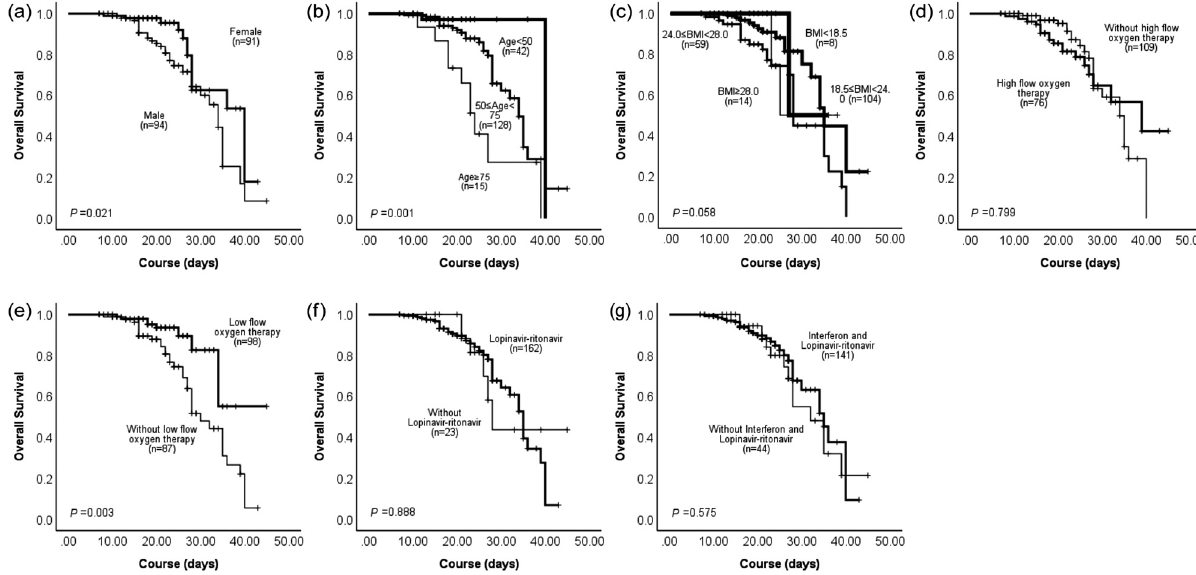
Figure 1: Kaplan – Meier analysis demonstrated that mortality was higher in older patients ( p = 0.001 ) , higher in men than in women ( p = 0.021 ) , and lower in the low - fl ow oxygen therapy group than in the non - low - fl ow oxygen therapy group. BMI had no in fl uence on mortality ( p = 0.058 ) , as well as high fl ow oxygen therapy, LPV/r therapy, and interferon - alpha add LPV/r therapy.